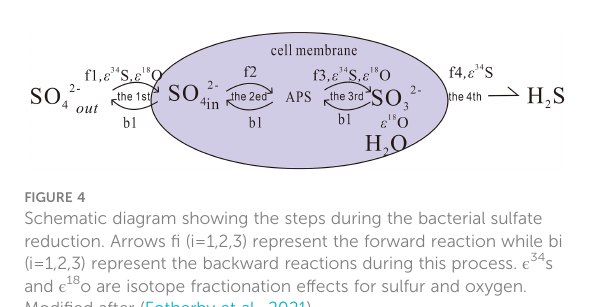
reduction. Arrows fi (i=1,2,3) represent the forward reaction while bi (i=1,2,3) represent the backward reactions during this process. ϵ 34 s and ϵ 18 o are isotope fractionation effects for sulfur and oxygen. Modi fi ed after (Fotherby et al.,